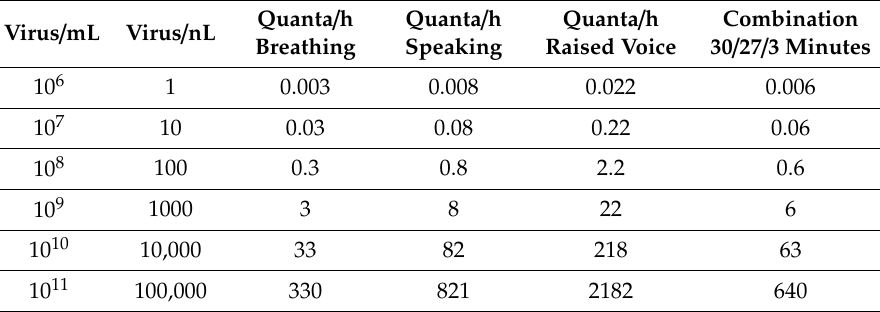
Table 5. Quanta released (q) as function of the starting virus concentration. Virus /